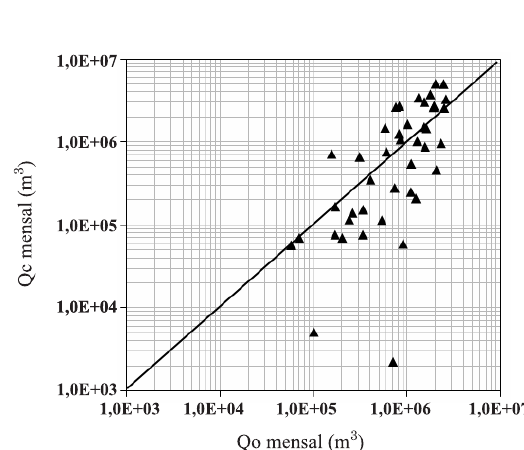
validação.Figura 8. Valores mensais do volume de escoamento direto observados e calculados na bacia do ribeirão Pipiripau, no período de